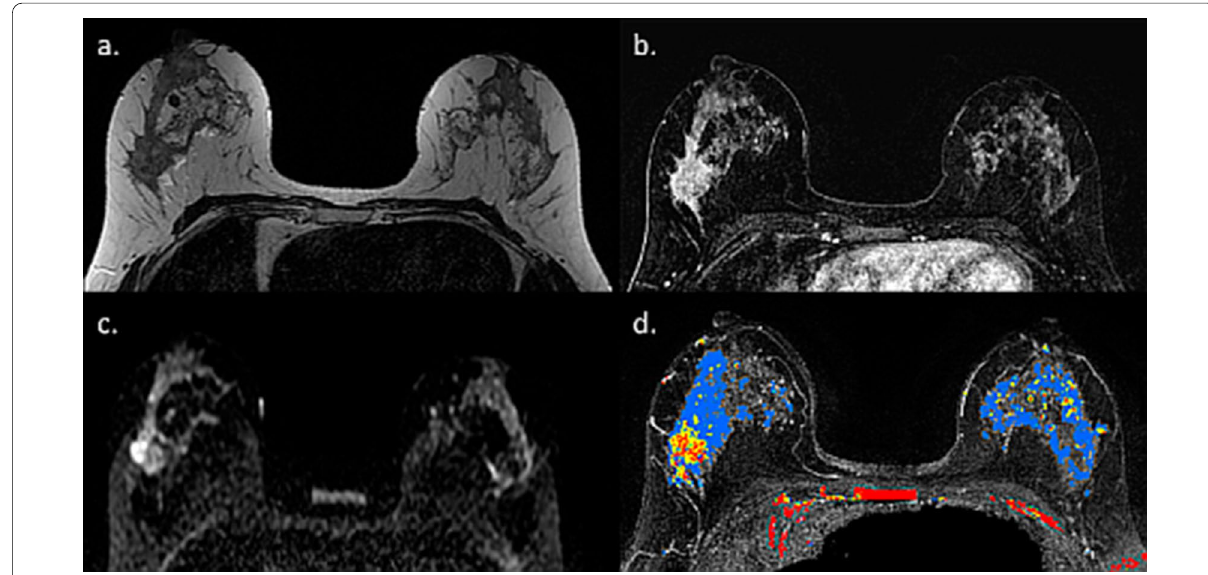
Fig. 10 MRI of PABC during pregnancy prior to elected abortion. Pre‑operative MR Images of a pregnant patient with newly diagnosed IDC are shown. T2 ( a ), subtraction DCE ( b ), DWI ( c ) and CAD ( d ) reveal extensive lesion on the right breast, on top of marked BPE on both breasts, as well false positive bilateral CAD coloring secondary to the increased